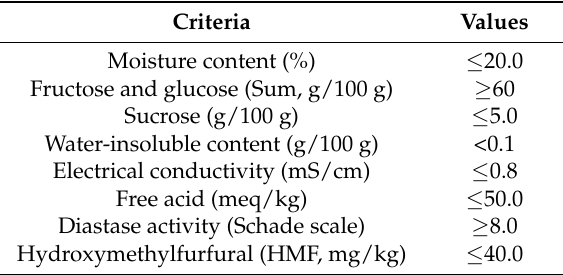
Table 2. Key compositional standards of blossom honey